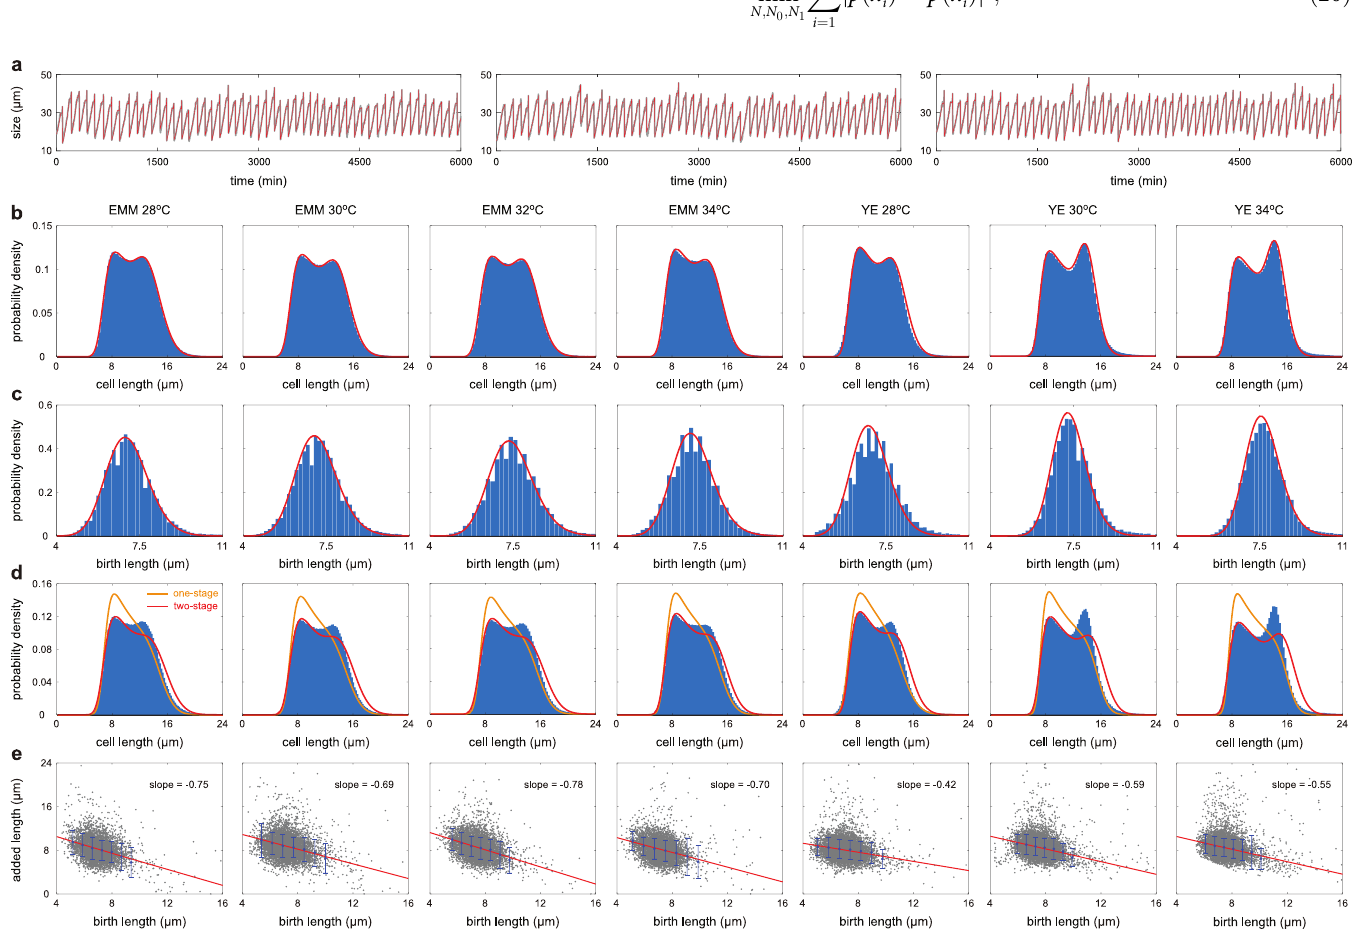
Fig 5. Fitting experimental data to theory based on the model with deterministic partitioning (model I). A : Fitting the time-course data of cell size (grey curve) to a three-stage growth model (red curve) for three typical cell lineages cultured in YE at 34˚C. B : Experimental cell size distributions (blue bars) and their optimal fitting to model I (red curve) for seven growth conditions. Here the theoretical distributions are computed using Eq (5). C : Same as B but for the birth size distributions. Here the theoretical distributions are computed using Eq (13). D : Fitting the experimental cell size distributions (blue bars) to the one-stage model with only the elongation phase (orange curve) and the two-stage model with only the elongation and septation phases (red curve). Here the theoretical distributions are computed using Eq (5) by taking r 0 = 1 and r 1 = 0 for the one-stage model and by taking r 1 = 0 for the two-stage model. Both simpler models fail to capture the shape of the cell size distribution. E : Scatter plot of the birth length versus the added length and the associated regression line. The slope of the regression line is significantly affected by outliers. To avoid this influence, we removed the outliers identified using Hadi’s potential-residual plot [77] and grouped the data into seven bins.